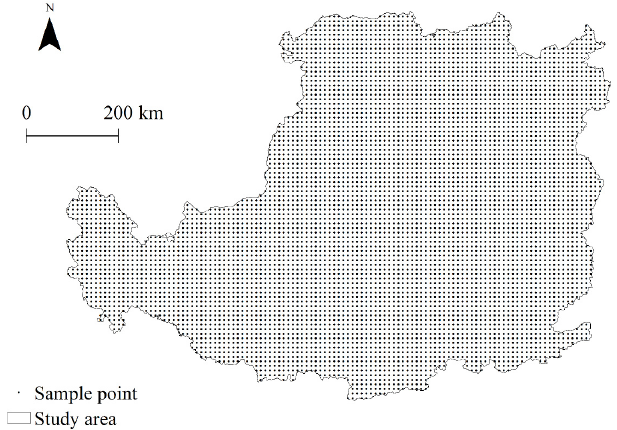
Figure 3. Sample points of the Loess Plateau.